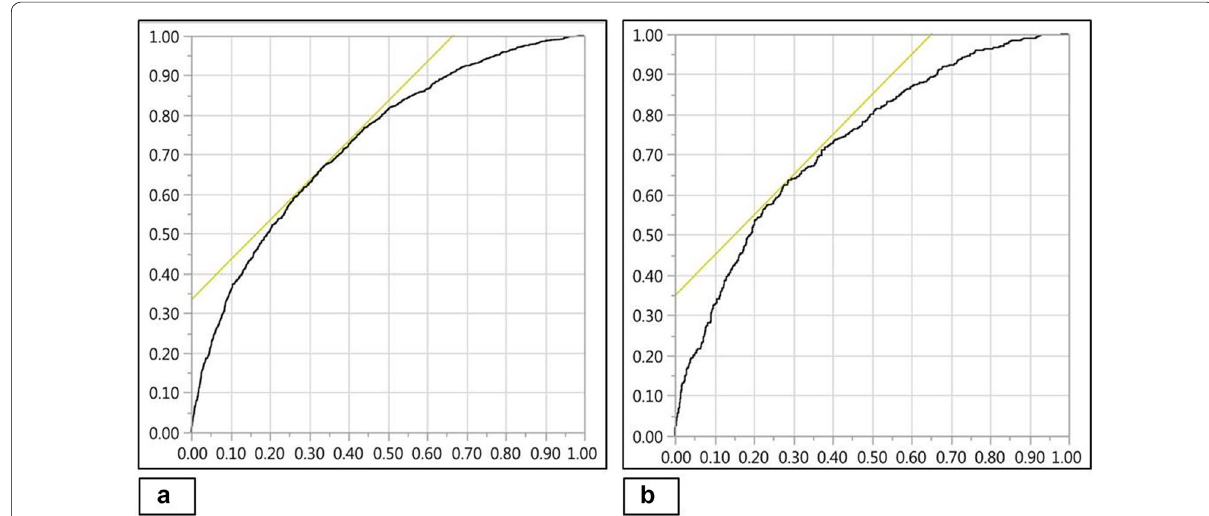
Fig. 4 Discriminatory ability of MAVIC model for 28-day mortality. AUROC curve for derivation ( a ) and validation cohorts ( b ) under receiver operating characteristic, MAVIC Mechanical ventilation, APACHE-III, Vasopressors, Inotropes and Charlson comorbidity